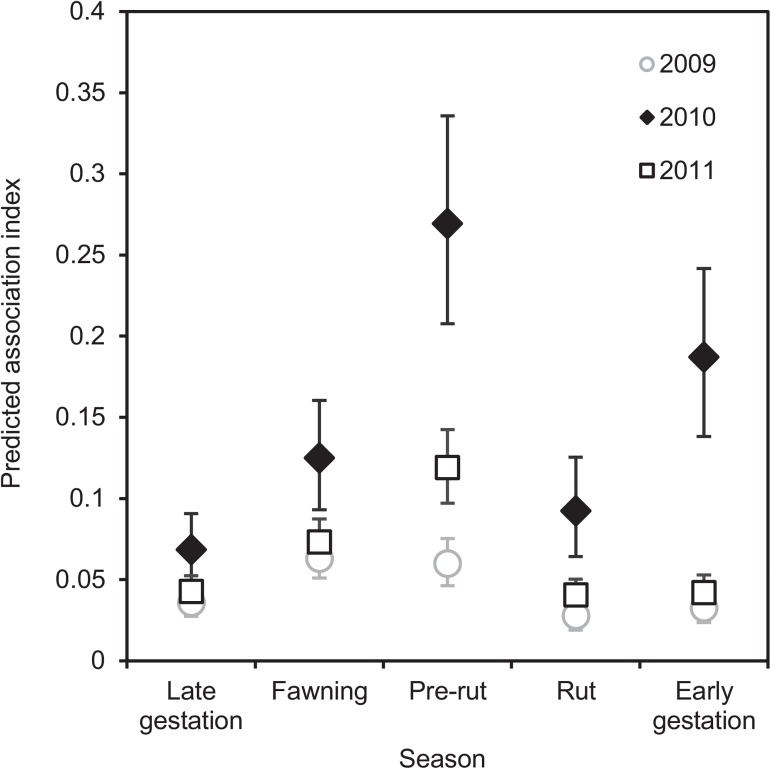
Seasonal predicted pairwise spatial association indices by year among adult mule deer.Error bars are 95% CI. For observed values, see S1 Fig; for values used to generate this graph, see Table H in S4 Appendix.